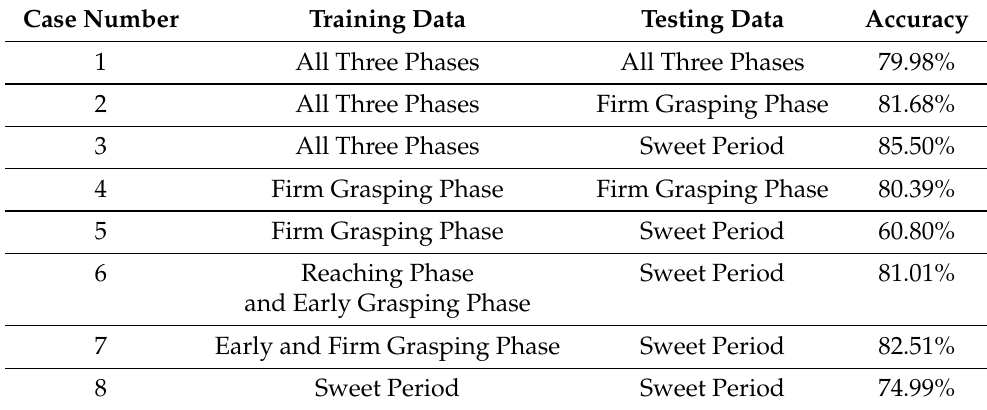
Table 3. Analysis Results for Six Cases. All Three Phases include signal from the time of 0 ms to 4500 ms, Firm Grasping Phase is from the time of 2000 ms to 4500 ms, sweet period is from the time of 1100 ms to 1400 ms. Leave-one-repetition-out cross-validation was employed for all cases, such that all testing data was excluded from training the